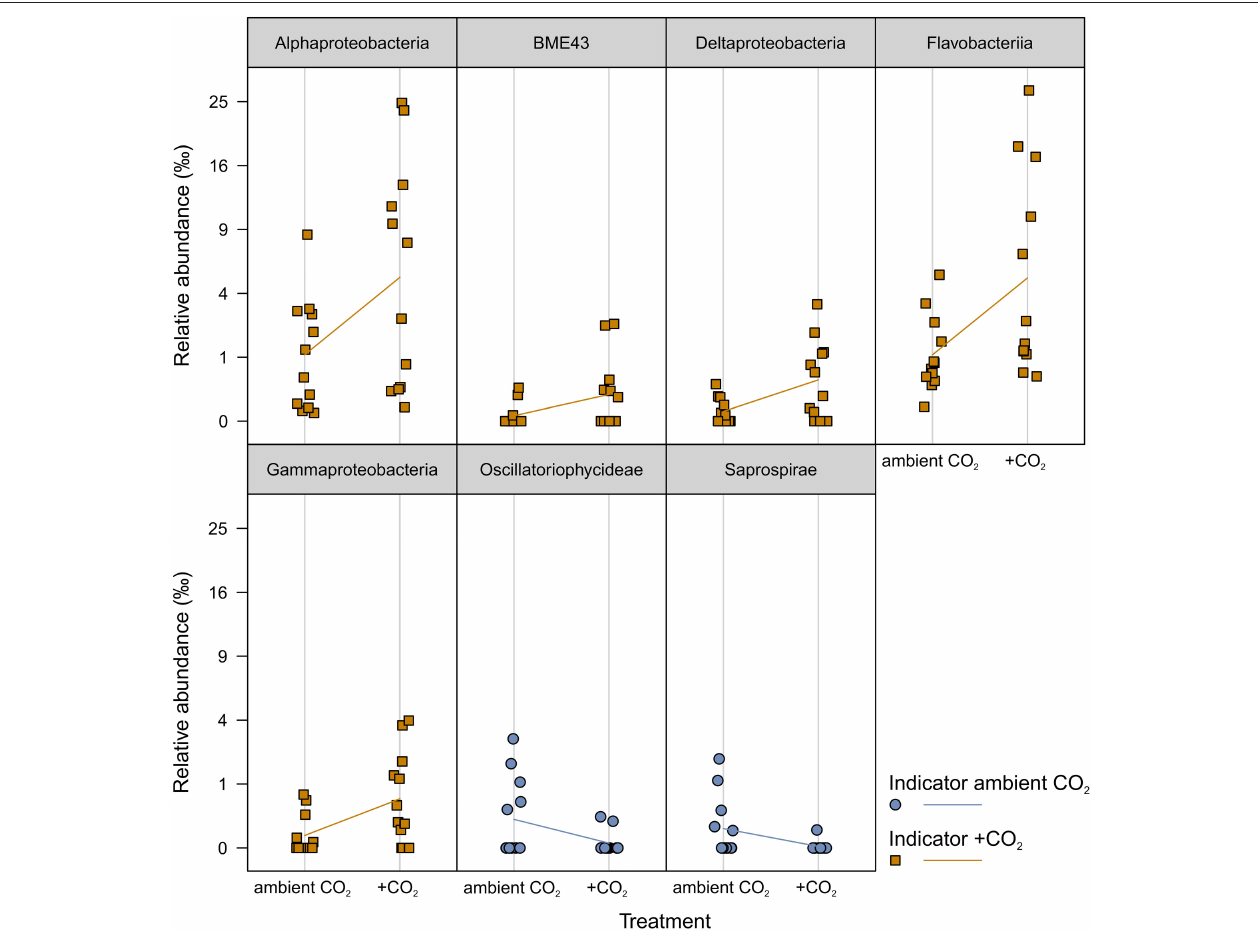
FIGURE 4 | Indicator OTUs (iOTUs) for p CO 2 on all samples. Relative abundances in ‰ of single iOTUs for ambient (blue circles) and elevated (orange squares) p CO 2 in week 8 summarized at class level ( q ≤ 0.05) per sample ( n = 12). Lines connect the mean relative abundances between both treatment levels. + CO 2 , elevated p CO 2